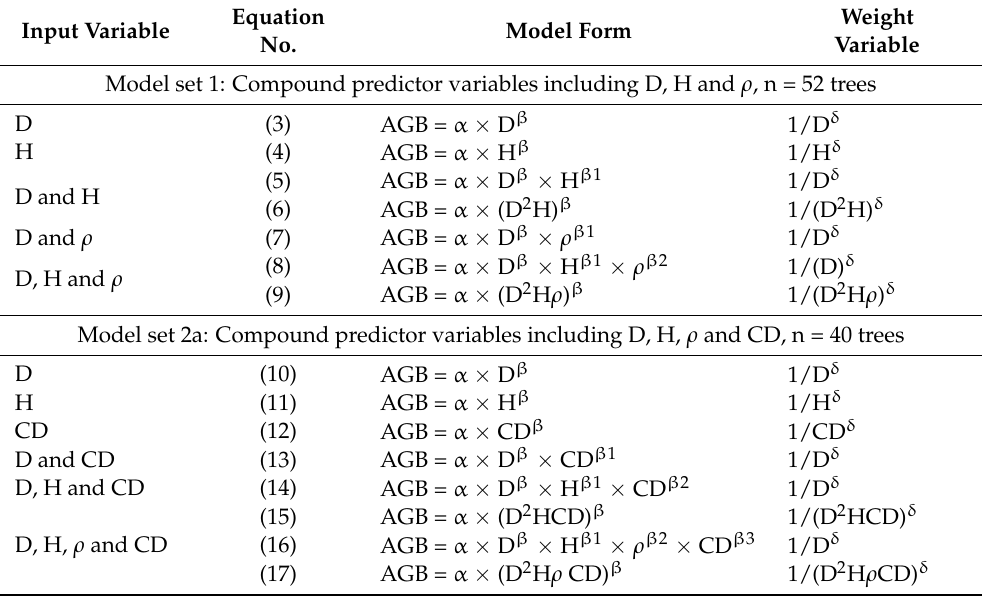
Table 2. Type of predictor models used to develop biomass allometric equations: D is diameter at breast height (cm), H is total tree height (m), ρ is wood density (kg m − 3 ), CD is crown diameter (m) CV is crown volume (cm 3 ), and δ is the variance function coefficient. Equation Weight Input Variable Model Form No. Variable Model set 1: Compound predictor variables including D, H and ρ , n = 52 trees